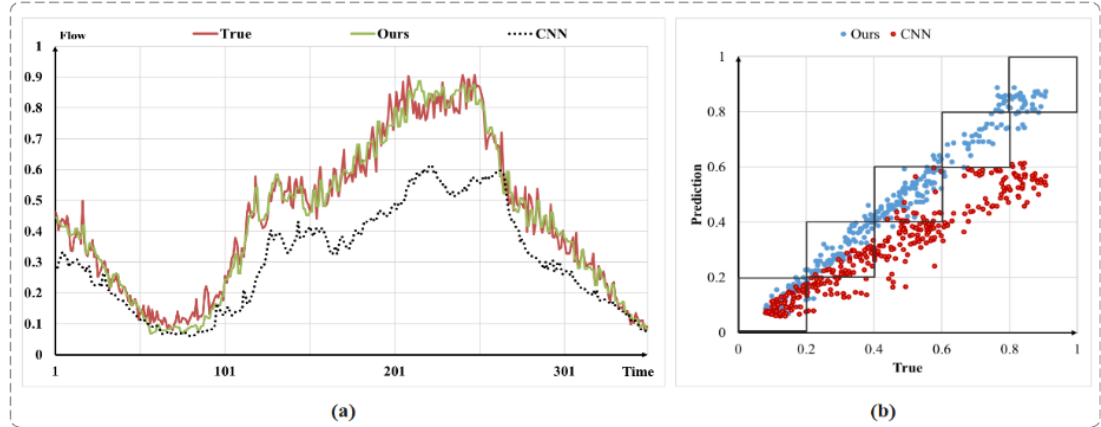
Figure 6. Comparison of DSGCN and CNN prediction effects. ( a ) is a time-series variation plot. ( b ) is a numerical scatter plot.